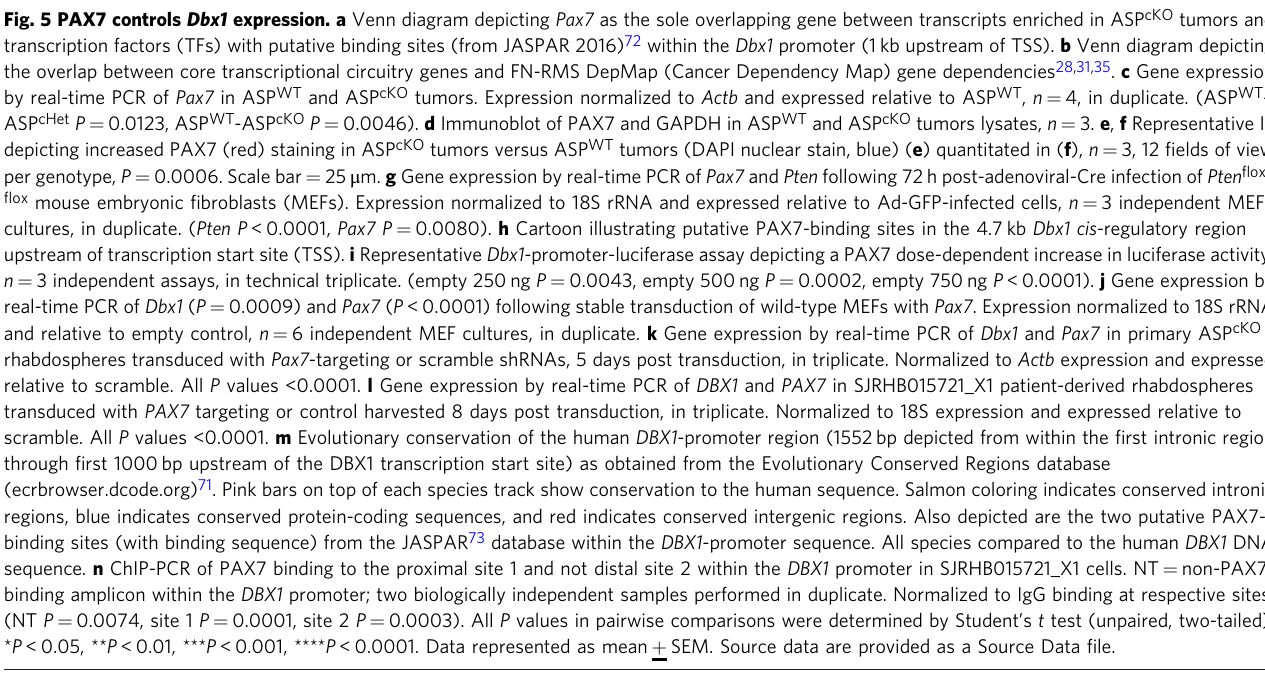
Fig. 5 PAX7 controls Dbx1 expression. a Venn diagram depicting Pax7 as the sole overlapping gene between transcripts enriched in ASP cKO tumors and transcription factors (TFs) with putative binding sites (from JASPAR 2016) 72 within the Dbx1 promoter (1 kb upstream of TSS). b Venn diagram depicting the overlap between core transcriptional circuitry genes and FN-RMS DepMap (Cancer Dependency Map) gene dependencies 28,31,35 . c Gene expression by real-time PCR of Pax7 in ASP WT and ASP cKO tumors. Expression normalized to Actb and expressed relative to ASP WT , n = 4, in duplicate. (ASP WT - ASP cHet P = 0.0123, ASP WT -ASP cKO P = 0.0046). d Immunoblot of PAX7 and GAPDH in ASP WT and ASP cKO tumors lysates, n = 3. e , f Representative IF depicting increased PAX7 (red) staining in ASP cKO tumors versus ASP WT tumors (DAPI nuclear stain, blue) ( e ) quantitated in ( f ), n = 3, 12 fi elds of view per genotype, P = 0.0006. Scale bar = 25 μ m. g Gene expression by real-time PCR of Pax7 and Pten following 72 h post-adenoviral-Cre infection of Pten fl ox/ fl ox mouse embryonic fi broblasts (MEFs). Expression normalized to 18S rRNA and expressed relative to Ad-GFP-infected cells, n = 3 independent MEF cultures, in duplicate. ( Pten P < 0.0001, Pax7 P = 0.0080). h Cartoon illustrating putative PAX7-binding sites in the 4.7 kb Dbx1 cis -regulatory